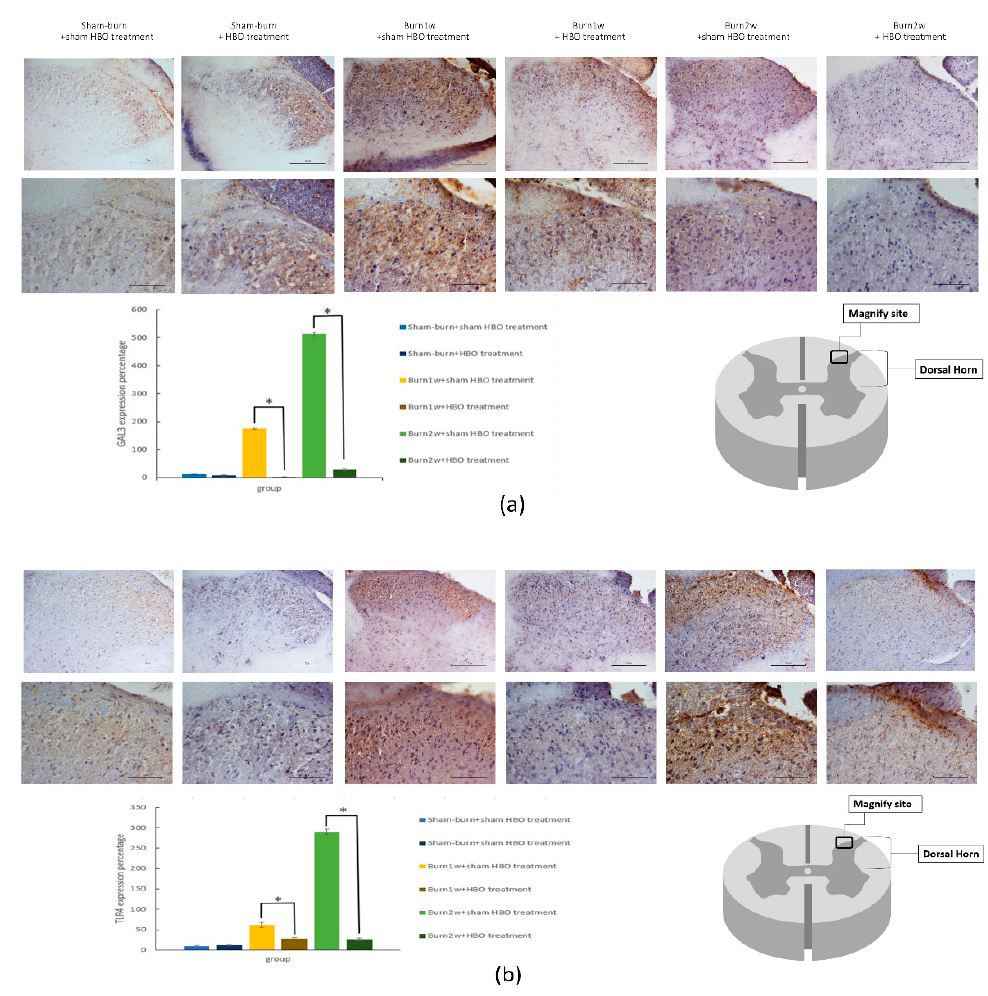
Figure 6. ( a , b ) HBO treatment inhibited the expression of GAL-3 and TLR-4 in spinal cord right dorsal horn histologic specimens. Immunohistochemistry (IHC) analyses of GAL-3 and TLR-4 in the spinal cord dorsal horn at one and two weeks after burn injury. GAL-3 and TLR-4 expression decreased significantly in the burn with HBO treatment group compared with the burn with sham HBO treatment group (* p < 0.05), original magnification: ×20 for upper part in ( a ) and ( b ), original magnification: ×40 for lower part in ( a ) and ( b ).